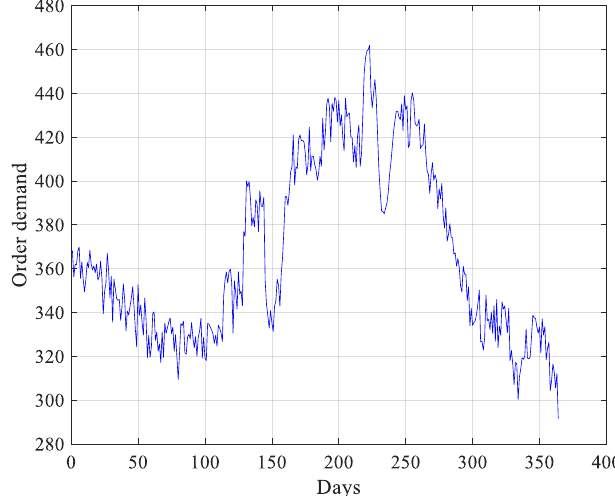
Figure 4. Original demand signal diagram .